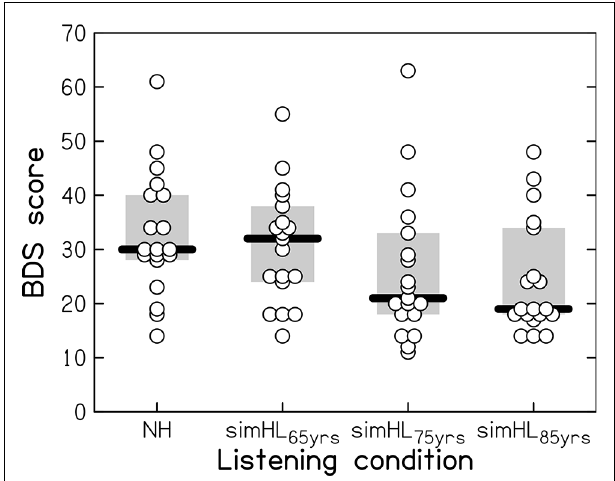
FIGURE 2 | Backward-Digit-Span (BDS) performance (with a maximum score of 70) as a function of listening condition: in the case of normal-hearing (NH) and with three progressively more severe simulated hearing losses, associated with the hearing sensitivity of the average 65-, 75-, and 85-year-old person (simHL 65yrs , simHL 75yrs , and simHL 85yrs , respectively). Horizontal thick bars indicate the median, the light-gray-shaded boxes represent the interquartile range, and the open circles denote individual data points. Overlapping data points are displaced horizontally for better